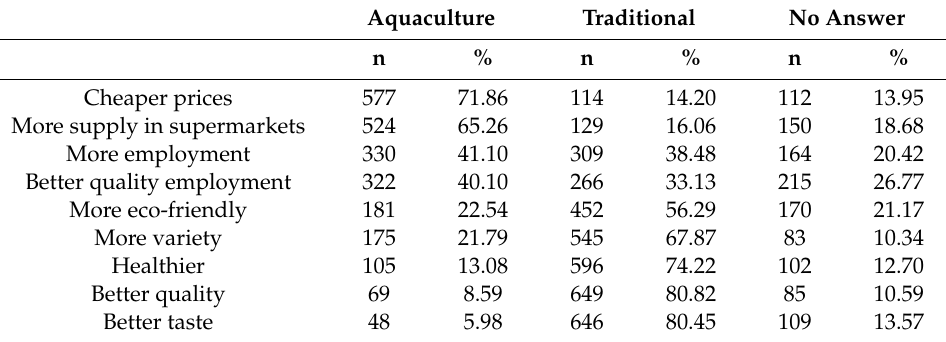
Table 7. Comparison of fish obtained from aquaculture / traditional